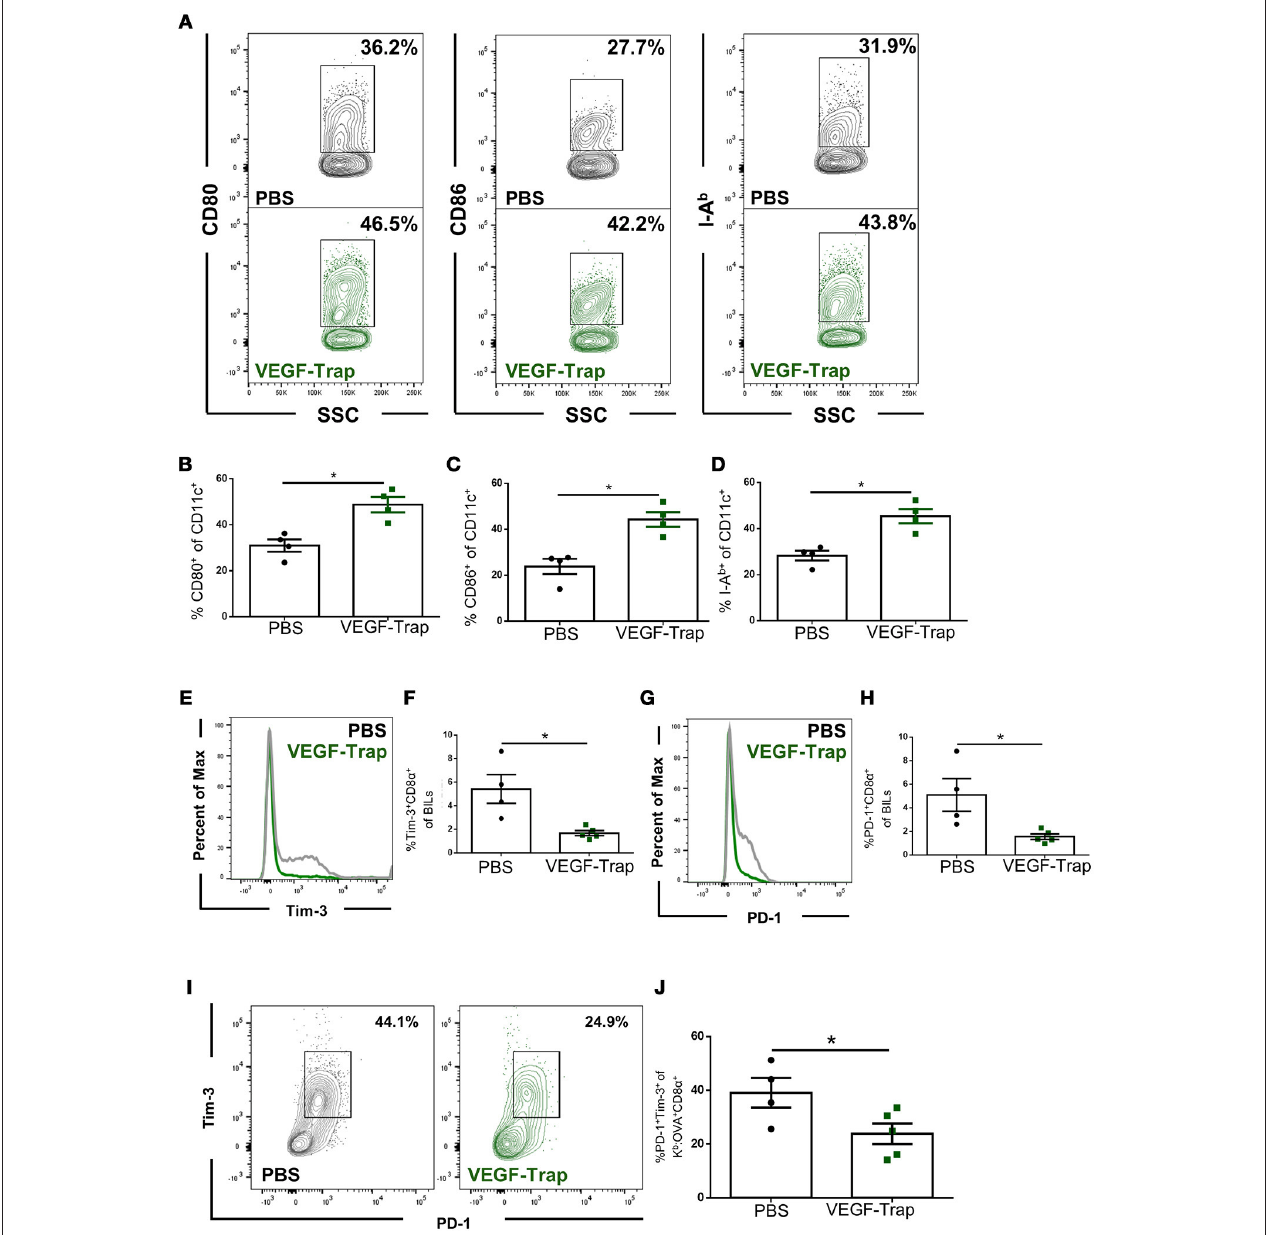
FIGURE 2 | CD8T cells and dendritic cells isolated from the brain of VEGF-Trap treated GL261-quad cassette bearing mice express a more functional phenotype. GL261-quad cassette bearing animals were treated with PBS ( N = 4) or VEGF-Trap ( N = 5) 2 weeks post-tumor implantation. Animals were sacrificed 30 days after tumor implantation and brain infiltrating leukocytes (BILs) were assessed by flow cytometry. (A) Representative images of CD11c + cells isolated from the brain assessing expression of costimulatory markers. VEGF-Trap treatment results in increased expression of CD80 (B) , CD86 (C) , and I-A b MHC Class II (D) . Representative flow plots (E) and quantification (F) show reduction in the proportion of Tim-3 + CD8T cells in the CNS of GL261-quad cassette bearing animals. Representative flow plots (G) and quantification (H) show a reduction in the proportion of CD8T cells expressing PD-1 in the brain. A reduction in PD-1 + Tim-3 + double positive CD8T cells was also observed (I,J) . Error bars represent mean ± SEM. * p < 0.05. Side Scatter (SSC) was included as a measure of